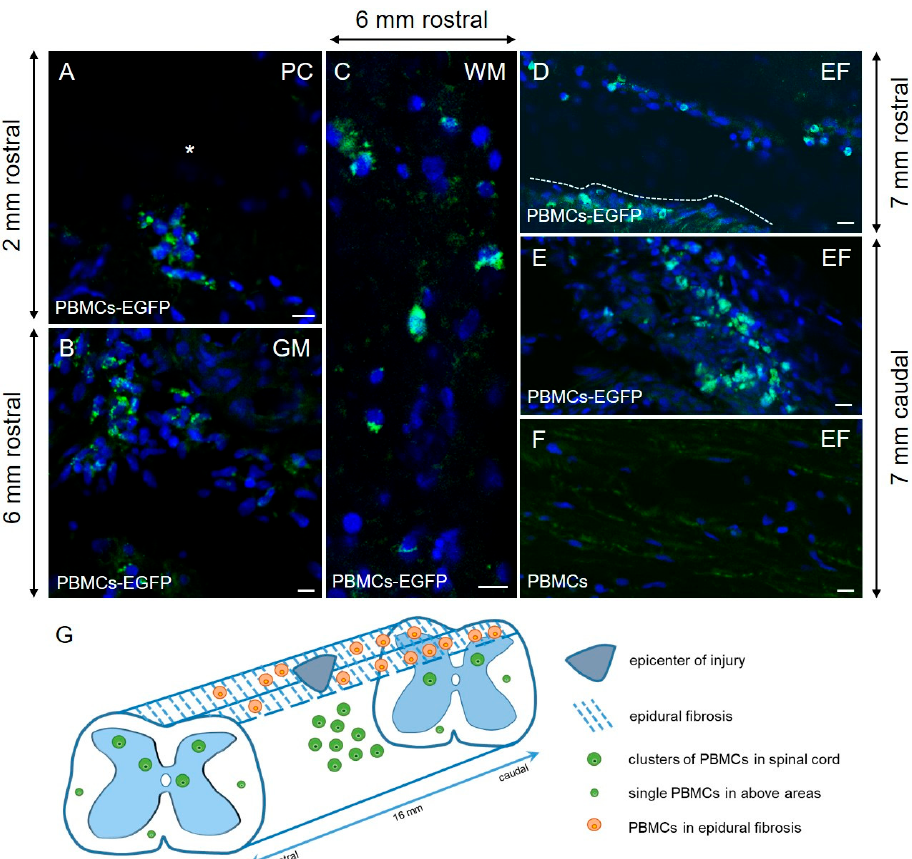
Figure 2. Distribution and survival of peripheral blood mononuclear cells (PBMCs)-EGFP in the area of spinal cord injuries (SCIs) in pigs. On day 14, Ad5–EGFP-labeled (green) PBMCs were located mainly in post-traumatic cavities (PC, asterisk) and around them at the epicenter of trauma ( A ). At a distance from the site of SCIs, EGFP-PBMCs were found mainly in the grey matter (( B ), GM) and in small amounts in the white matter (( C ), WM). The EGFP-PBMCs distribution can be seen in the area of epidural fibrosis ( E ); fewer EGFP + -cells were found above the rostral part of the spinal cord (( D ); the dashed line indicates the dorsal surface of the spinal cord), and more in the synechias above its caudal part ( E ). The area of epidural fibrosis in pigs applied with Ad5–EGFP-unlabeled PBMCs is shown in ( F ). Nuclei are stained with 4 (cid:48) ,6-diamidino-2-phenylindole (DAPI, blue). Scale bars: 10 µ m. Schematic presentation of the EGFP-PBMC distribution in the area of epidural fibrosis and spinal cord tissue according to the distance from the site of injury ( G